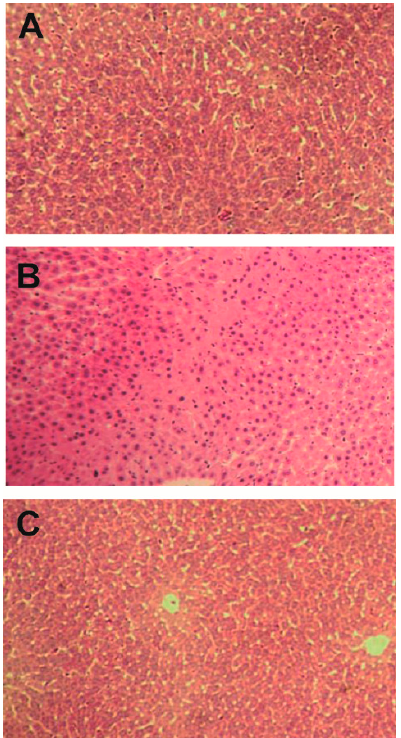
Figure 3. Effect of bicyclol on liver injury induced by anti-TB drug in rats. ( A ) Control rats; ( B ) Anti-TB drug intoxicated rats; and ( C ) Rats treated with bicyclol (200 mg/kg). Hematoxylin and eosin staining; Original magnification, ×40.